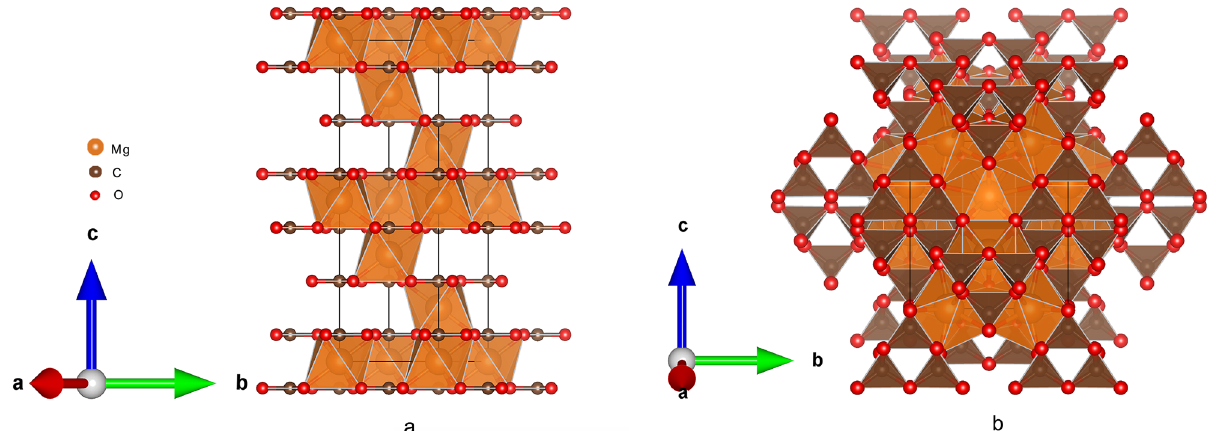
Figure 1. Crystal structures of magnesite ( a ) and magnesite-II ( b ).